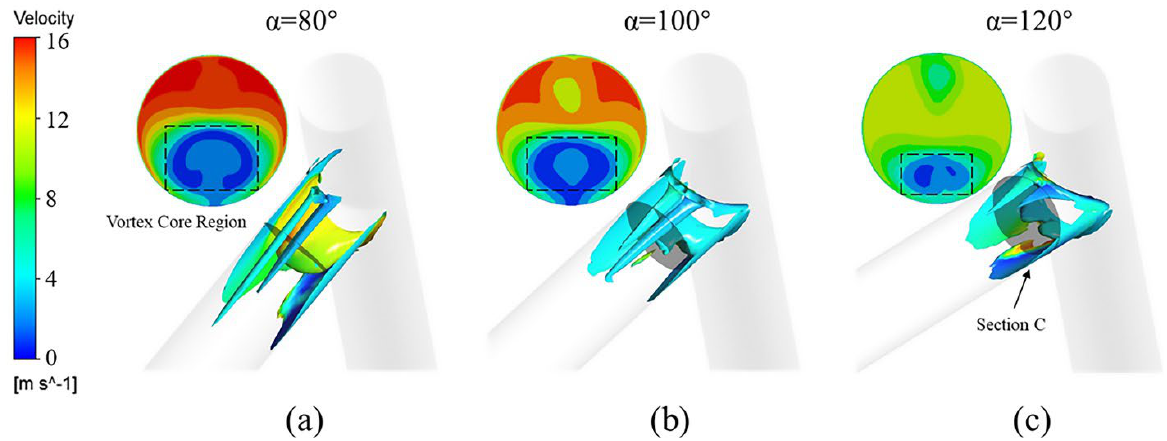
Figure 18. The effect of various angle α on the flue vortex structure. ( a ) α = 80°; ( b ) α = 100°; ( c ) α = 120°.